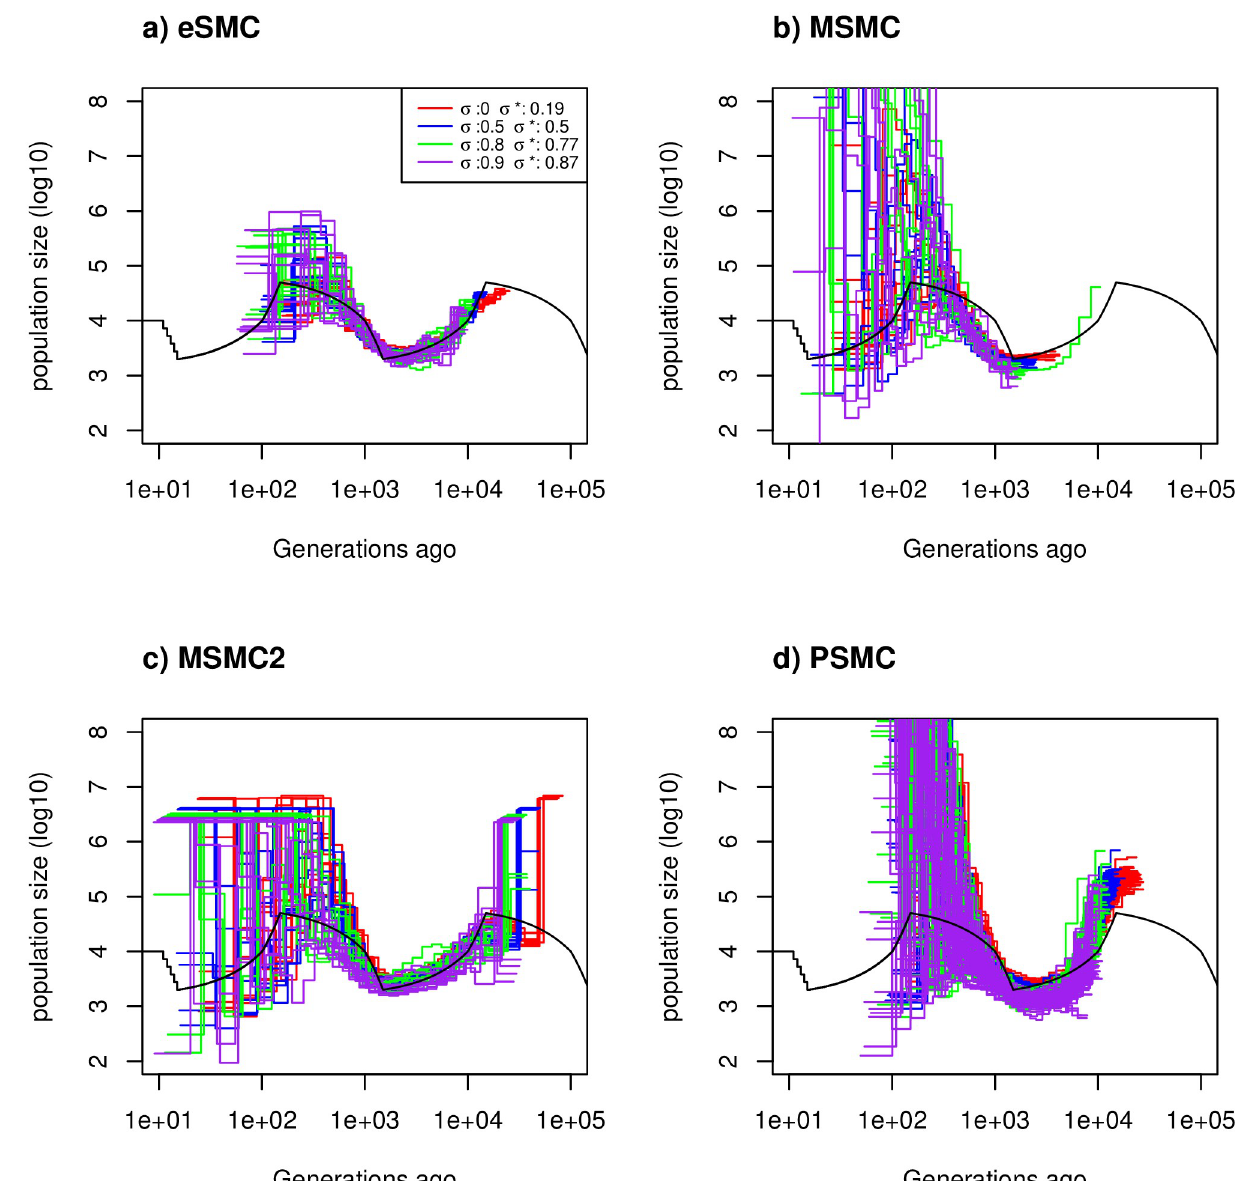
Fig 3. Estimated demographic history with selfing. Estimated demographic history using four simulated sequences of 10 Mb and ten replicates under a saw-tooth demographic scenario (black). The mutation and recombination rates are set to 1.25 × 10 − 8 per generation per bp, and simulations were run for four different self-fertilization rates ( σ = 0 (red), 0.5 (blue), 0.8 (green) and 0.9 (purple)), and as r respectively. The demographic history is estimated using a) eSMC, b) MSMC, c) MSMC2 and d) PSMC’. σ � represents the self-fertilization rate estimated by